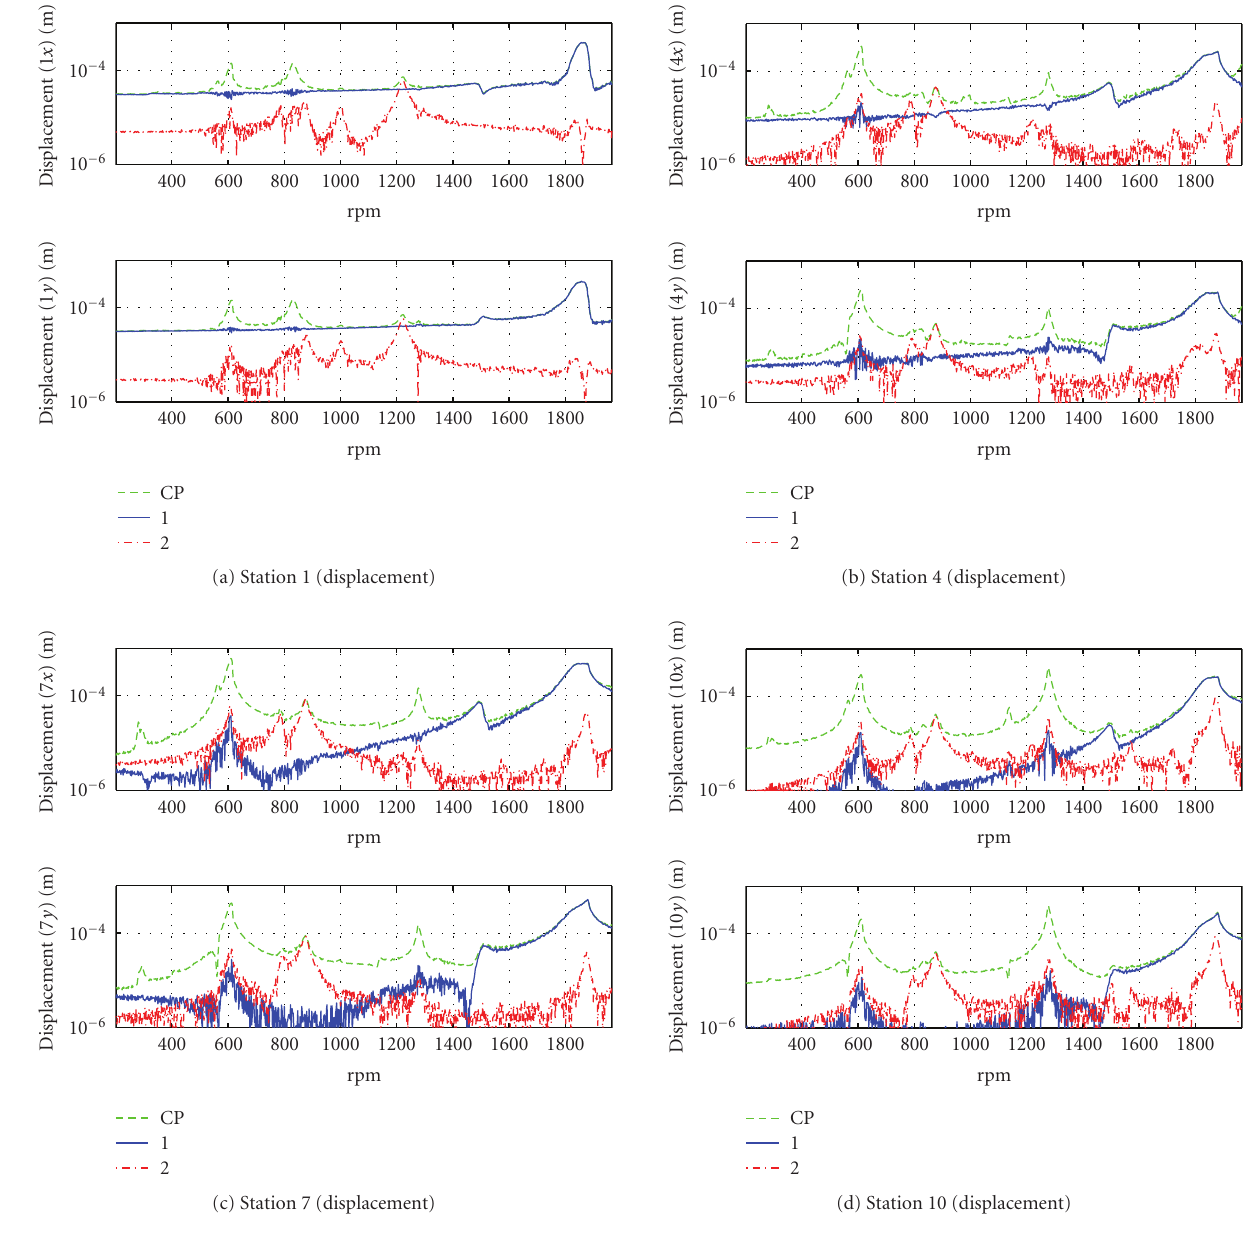
Figure 11: Order tracking measurements (rotor 1 reference, stations 1, 4, 7, and